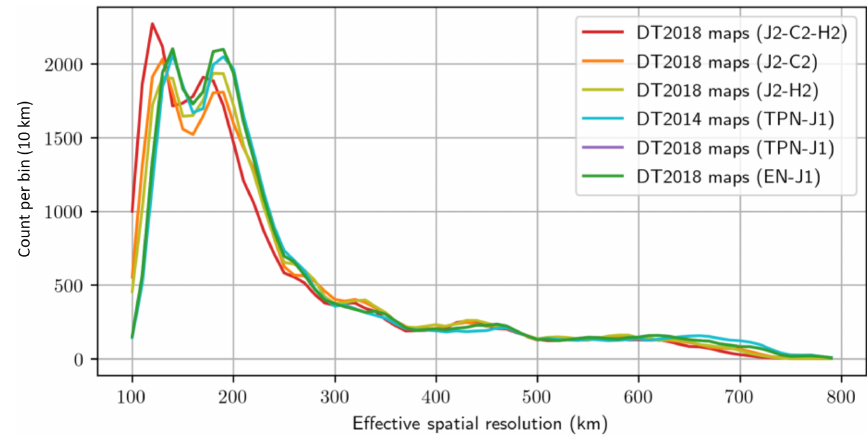
Figure 7. Distribution of the effective spatial resolution for various altimeter merging configuration.